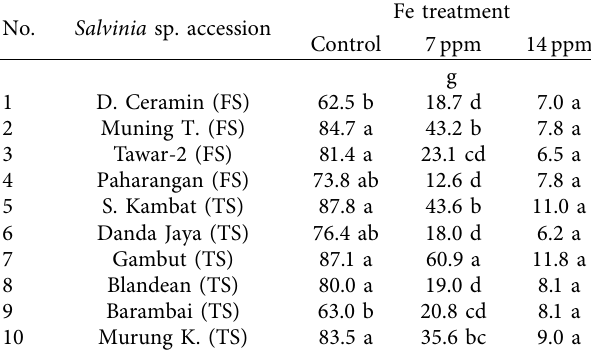
Table 2: Biomass (fresh weight) of Salvinia sp. after 4 weeks of maintenance in Hoagland nutrient solution medium enriched with various levels of